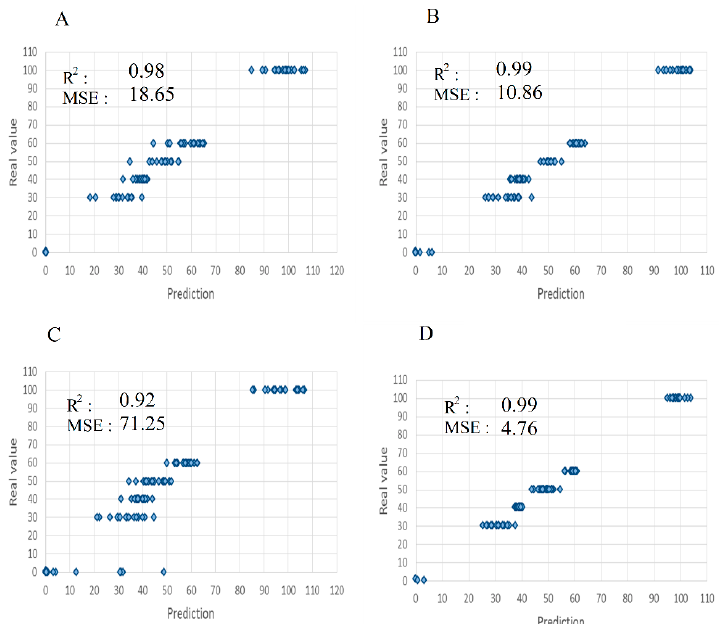
Figure 14. The real value of the zinc content in the target (wt%) on the ‘y’ axis and the prediction of the zinc content (wt%) of the target composition in the ‘x’ axis, R-squared (R2), and mean squared error (MSE) of the models predictions. ( A ) Original min max scaled spectral data turned into a 2D matrix, ( B ) SOM generated image, ( C ) SOM_SVD generated image from the first layer singular value decomposition reconstruction of the original data, ( D ) Original_SVD image generated from the first layer of the singular value decomposition reconstruction. The results of predicting the indium concentration in the target are presented in Figure 15. Once again, we can see that the SVD reconstruction of the SOM-formed images performed less effectively. Figures 16 and 17, respectively, demonstrate the predictions of the gas-flow rate and plasma power.